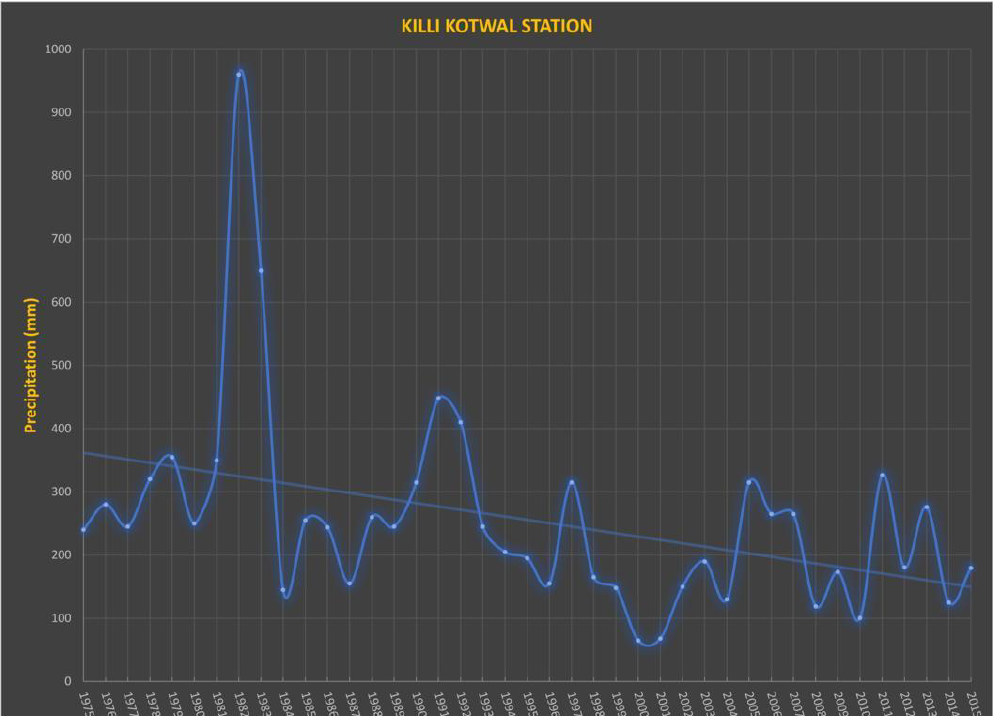
Figure 11. Graph showing the precipitation data, precipitation gauge is located in Killi Kotwal Station in Quetta. Drought can be seen from the year 1998–2004 whereas heavy precipitation in